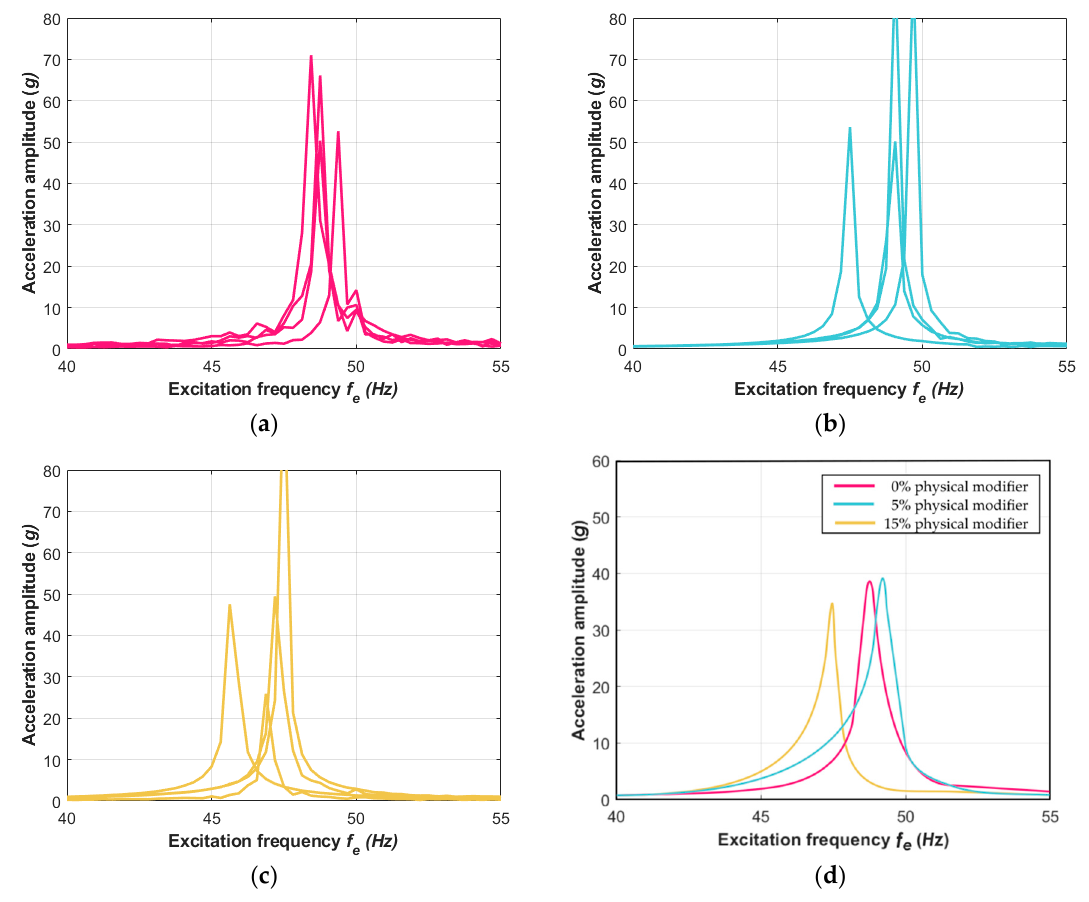
Figure 9. Second experiment method outcomes of the tests of samples ( a ) without the physical modifier and the samples that included ( b ) 5% and ( c ) 15% of the physical modifier, respectively. ( d ) The mean values of selected characteristics for each case of physical modifier are also included.